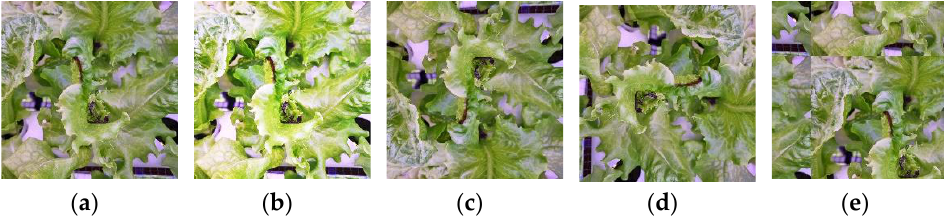
Figure 2. The data augmentation performed in this experiment: ( a ) original image; ( b ) increase image brightness; ( c ) flipped image vertically; ( d ) rotated image 90° clockwise; ( e ) shifted image horizontally and vertically.